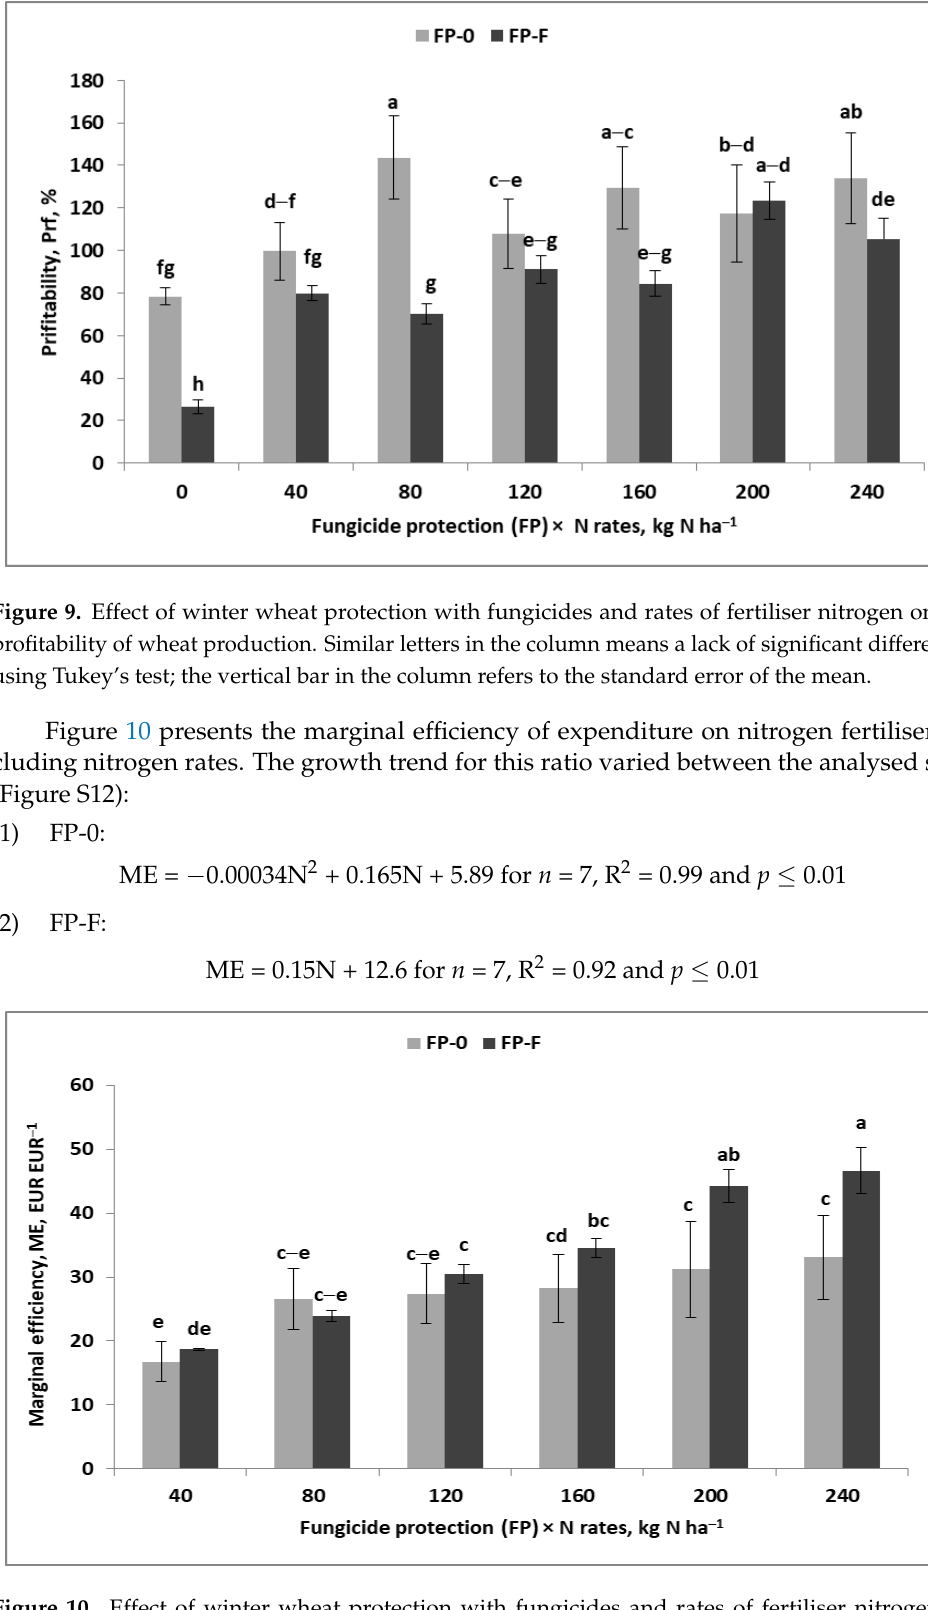
Figure 10. Effect of winter wheat protection with fungicides and rates of fertiliser nitrogen on marginal efficiency of wheat production. Similar letters in the column means a lack of significant differences using Tukey’s test; the vertical bar in the column refers to the standard error of the mean.